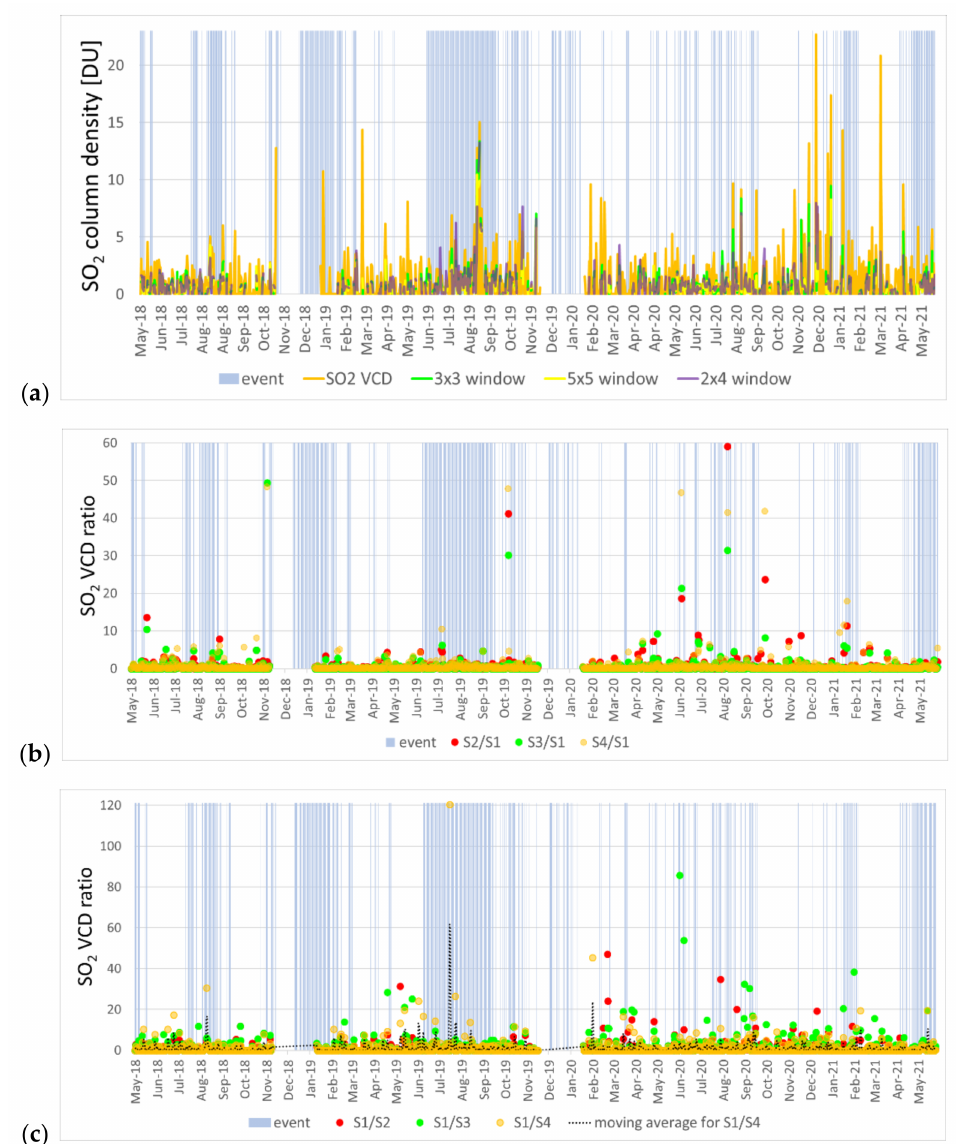
Figure 3. ( a ) Comparison of TROPOMI SO 2 vertical column density (VCD) observations in May 2018– May 2021 for the main crater of Stromboli, by sampling at a single pixel centered at the crater (S1) and using three averaging windows (i.e., S2, S3 and S4; i.e., calculated over 3 × 3, 5 × 5 and 4 × 2 windows, respectively). Ratios between observations at the single pixel and within the averaging windows: ( b ) S2/S1, S3/S1 and S4/S1; and ( c ) S1/S2, S1/S3 and S1/S4. Peaks visible in the single pixel time series decrease rapidly with increasing window